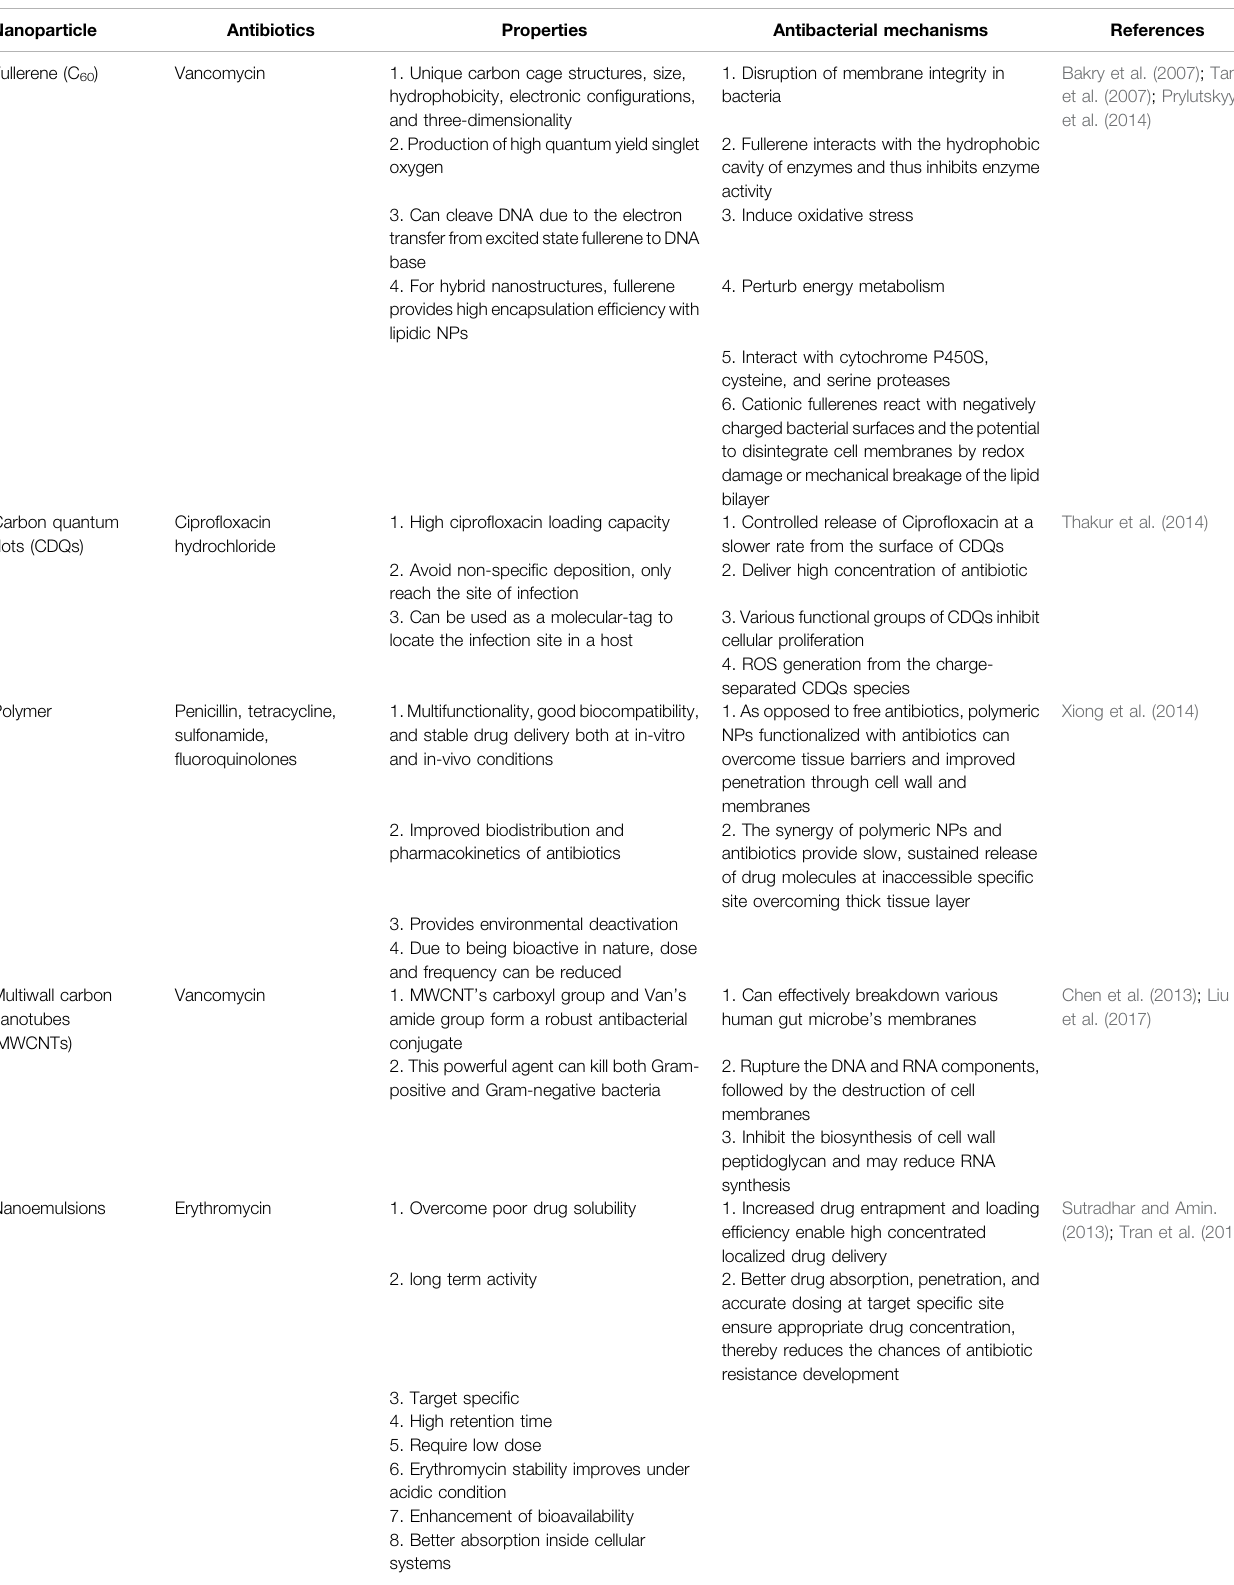
TABLE 9 | Future potentials of nanoparticle-antibiotics